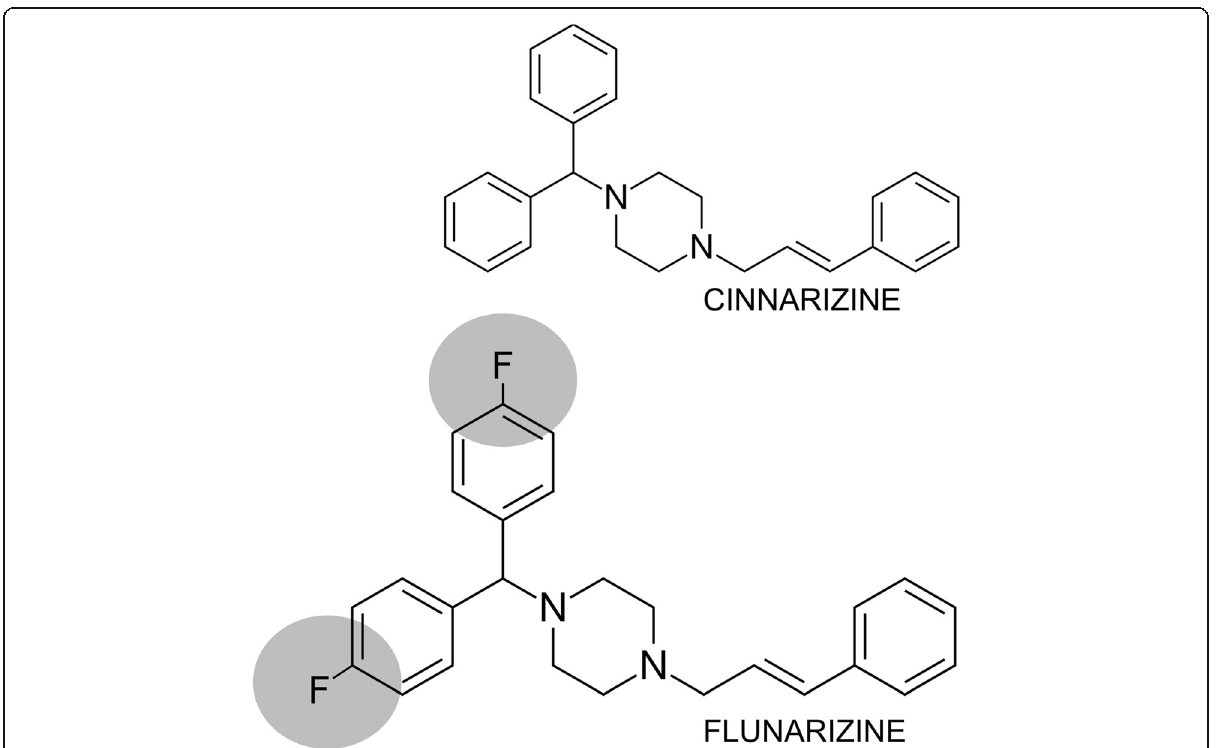
Fig. 1 Skeletal formula of cinnarizine and